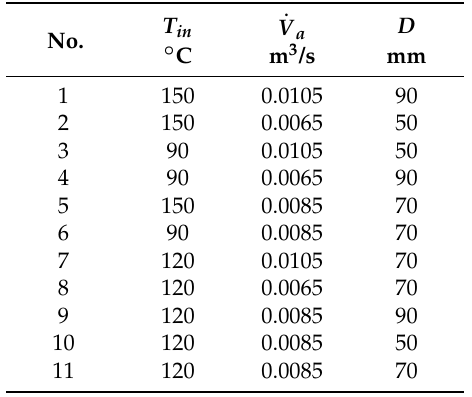
Table 2. Hartley design matrix for the experimental